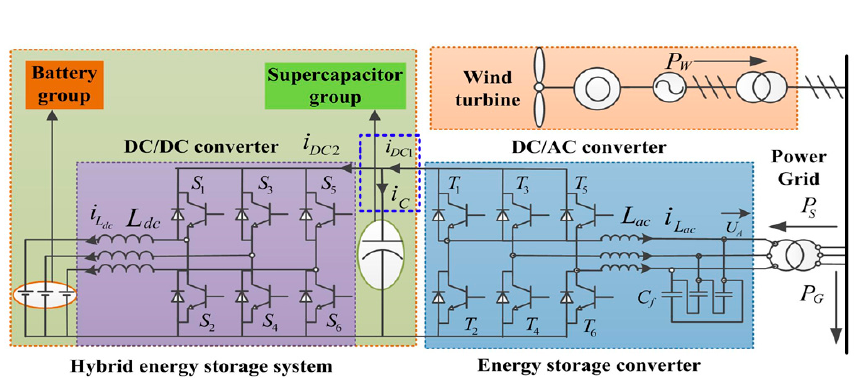
Figure 1. Overall structure of the wind power regulation system.